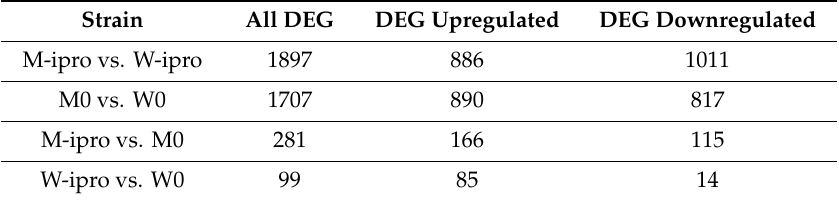
Strain All DEG DEG Upregulated DEG Downregulated M-ipro vs. W-ipro 1897